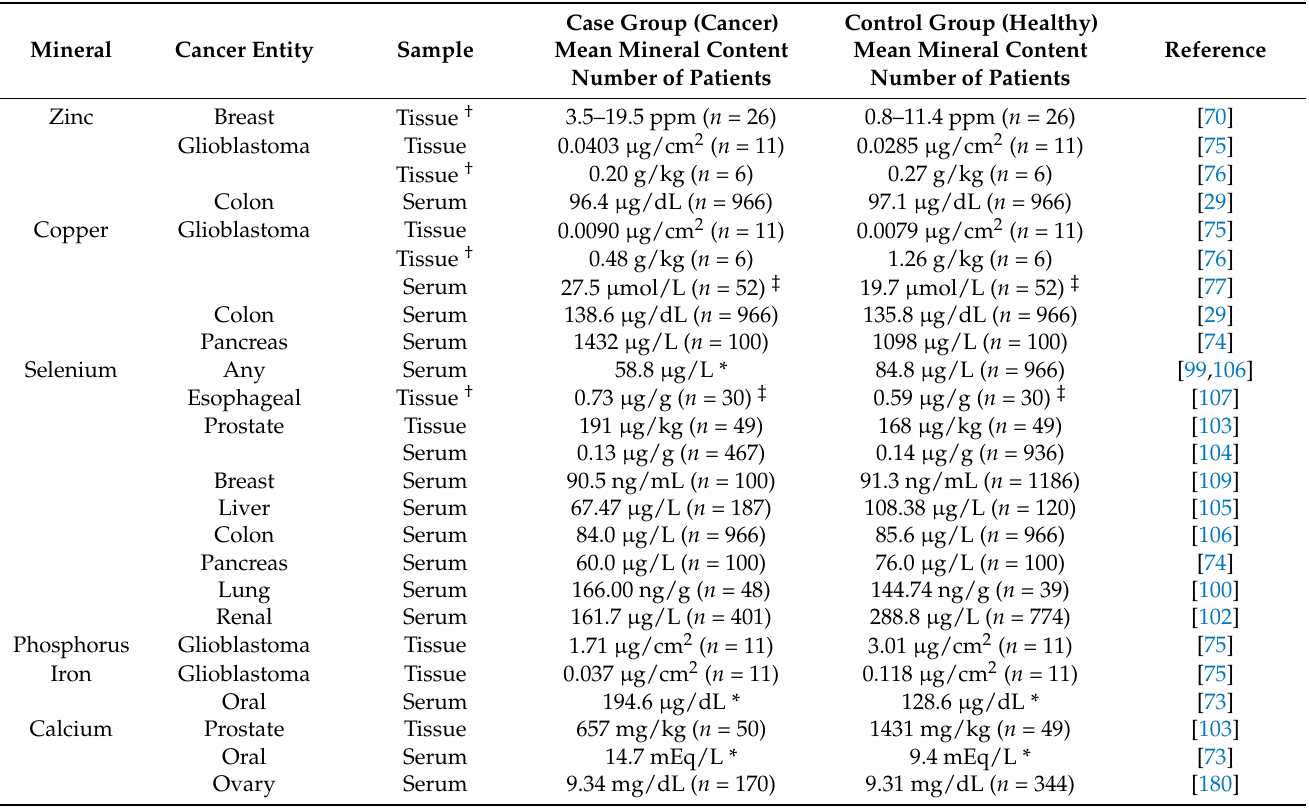
Table 3. Summary of the mineral levels in the studies retrieved for the present work.